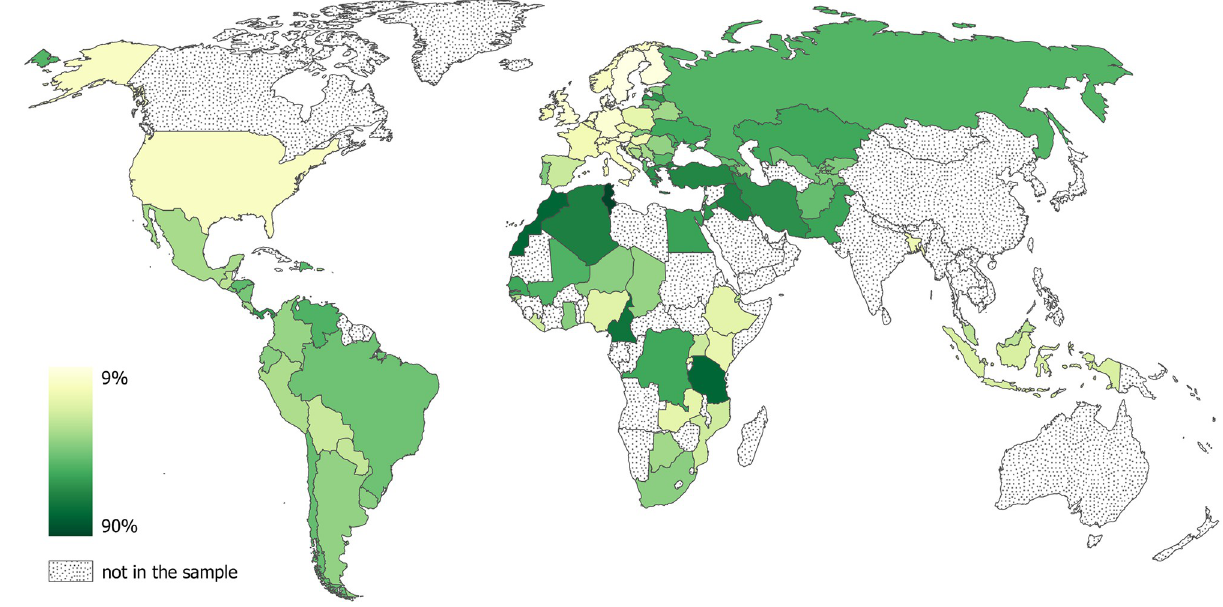
Fig 1. Witchcraft beliefs around the world. Author’s work using country basemap from https://www.naturalearthdata.com.